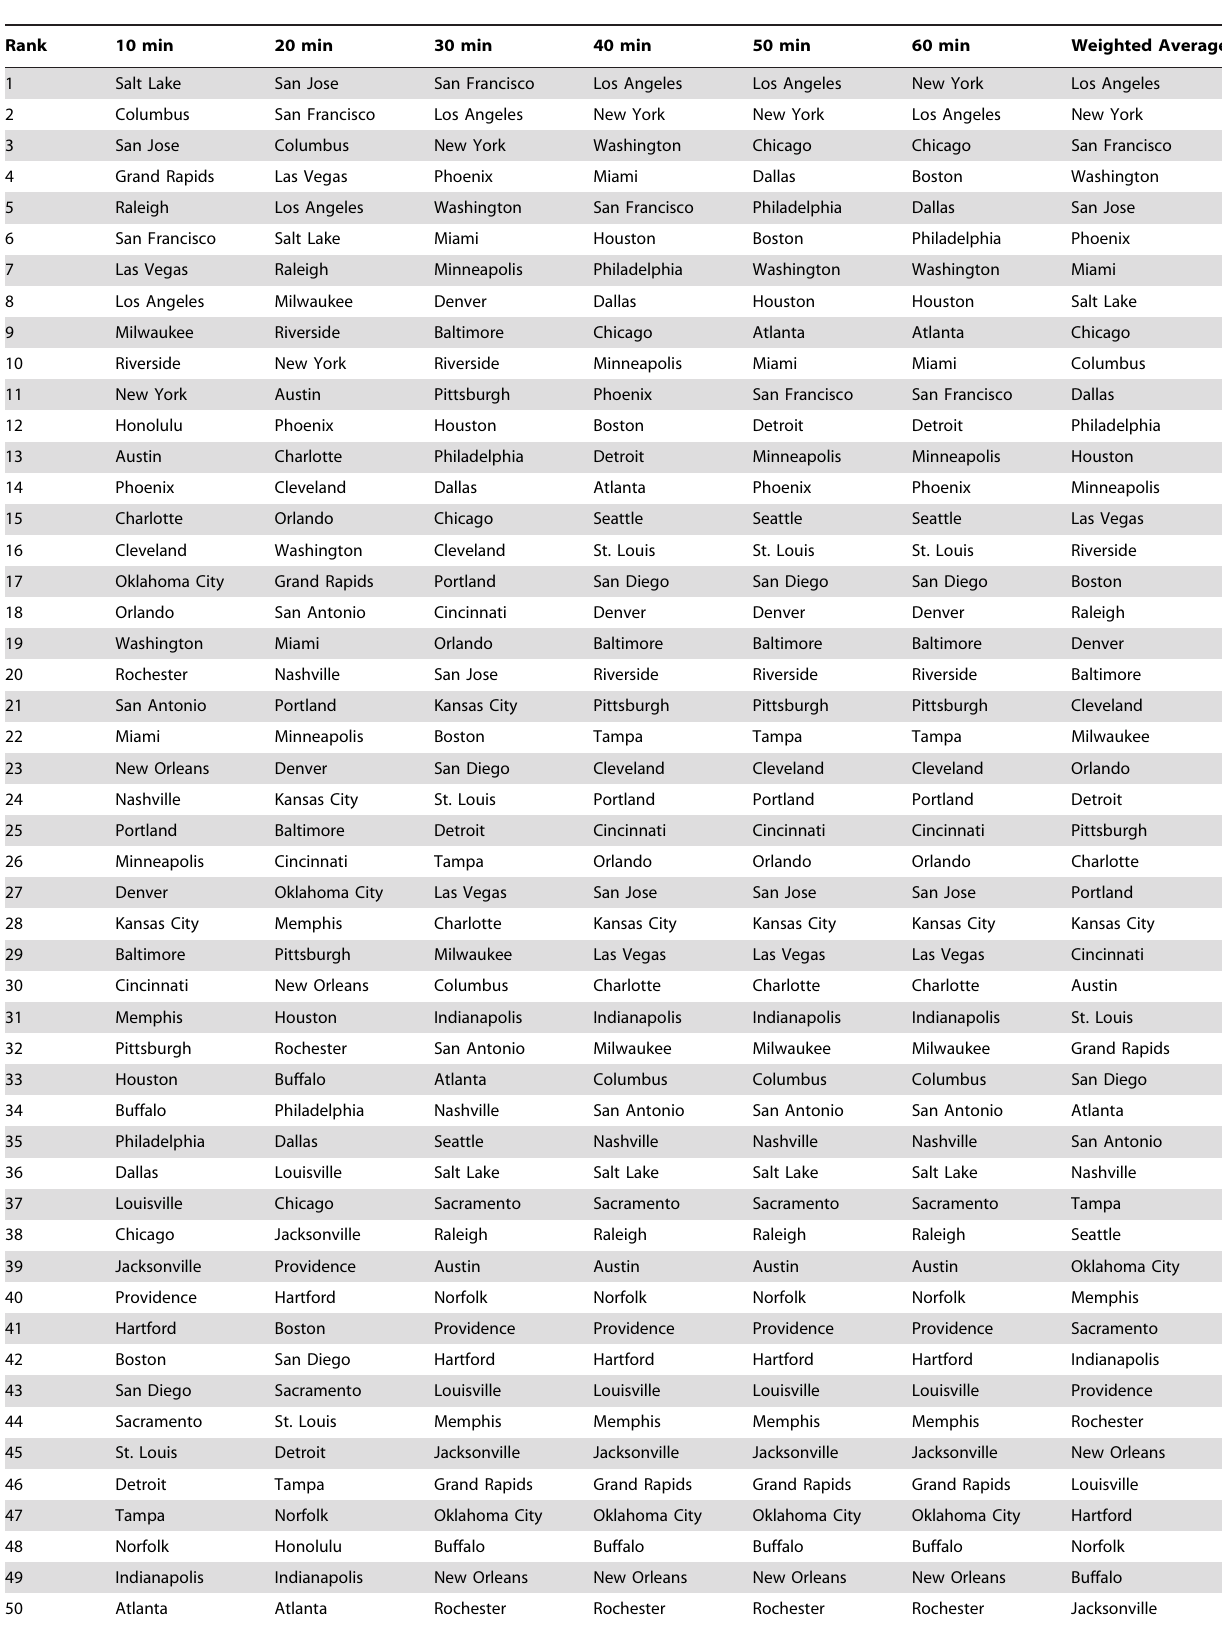
Table 3. American Metropolitan Areas Ranked by Accessibility to Jobs by Automobile in 2010.